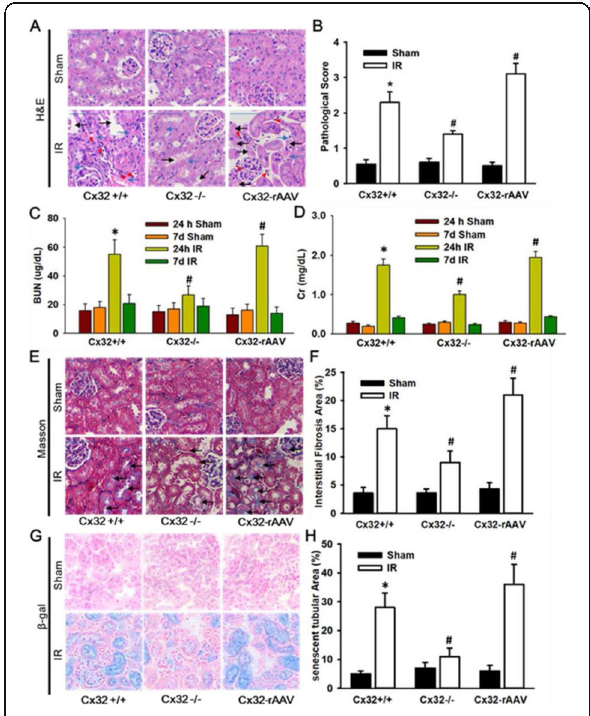
Fig. 1 (abstract 000565). Cx32 deficiency Attenuated AKI and renal fibrosis after renal IR with Concomitant Reduction of Post-Renal IR cellular senescence